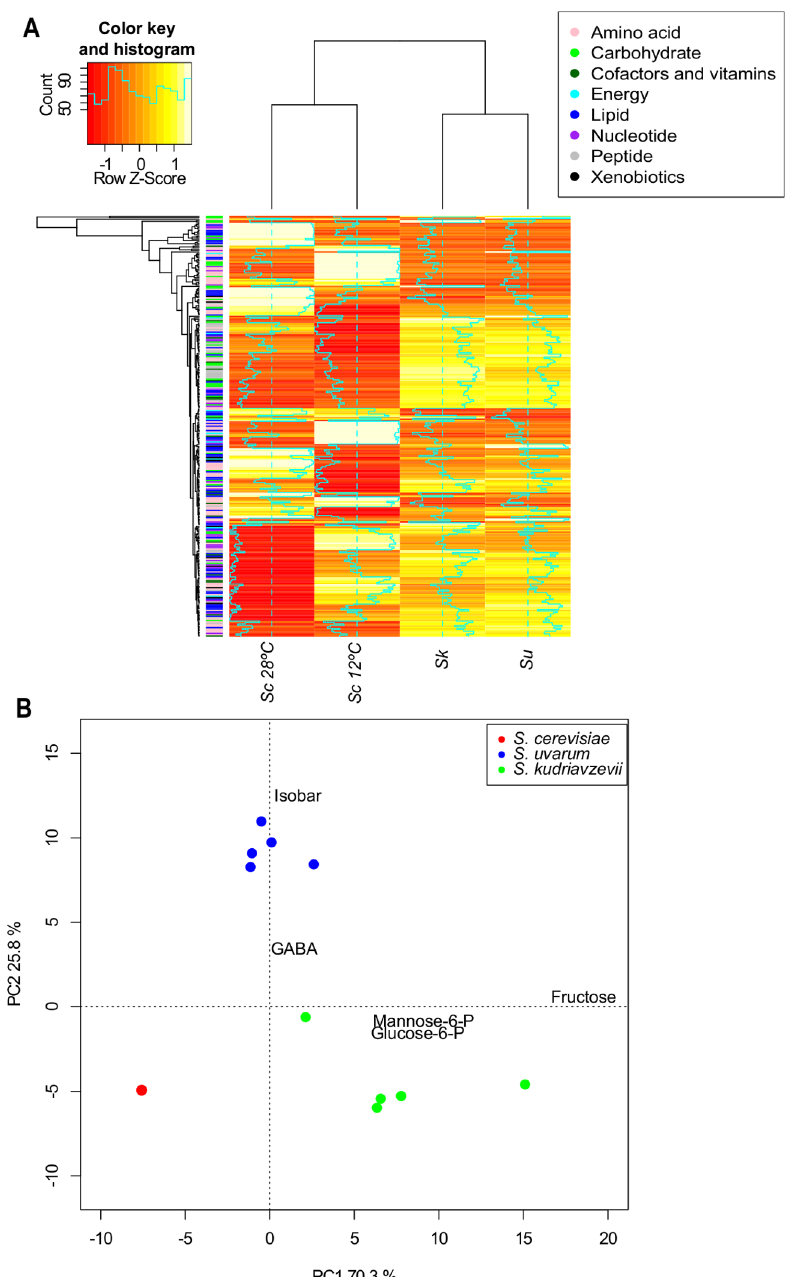
Figure 1. Global biochemical profiles comparison made of the three species. A ) Hierarchical clustering of all the species is computed after standardizing metabolites to the Z-score. B ) Biplot of the first two components of the PCA according to the metabolic composition. Isobar = isobaric compounds fructose 1,6-diphosphate, glucose 1,6-diphosphate and myo-inositol 1,4 or 1,3 diphosphate.